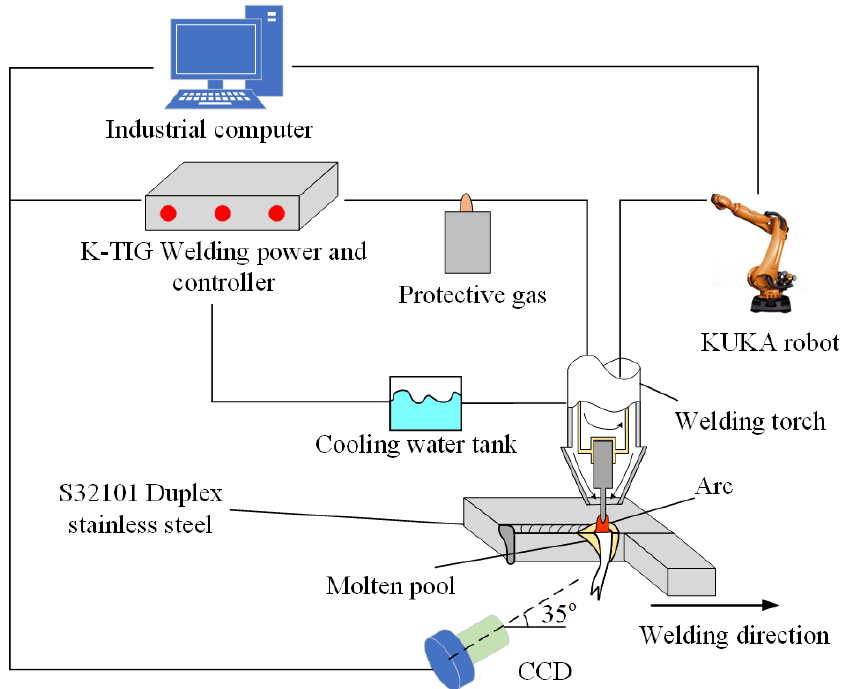
Figure 2. The K-TIG welding